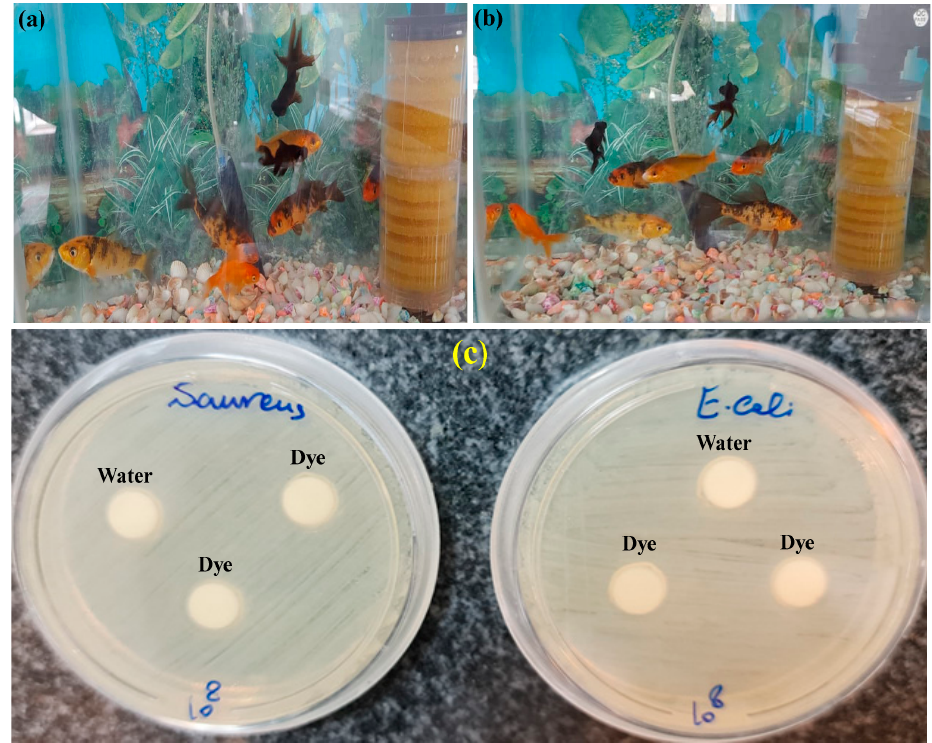
Figure 9. Examining the effect of toxicity of aqueous solution containing by-products of degraded dyes on aquarium fish ( a ) duration of 7 days and ( b ) duration of 20 days, ( c ) effect of toxicity of treated aqueous solution on microorganisms S. aureus and E. coli.